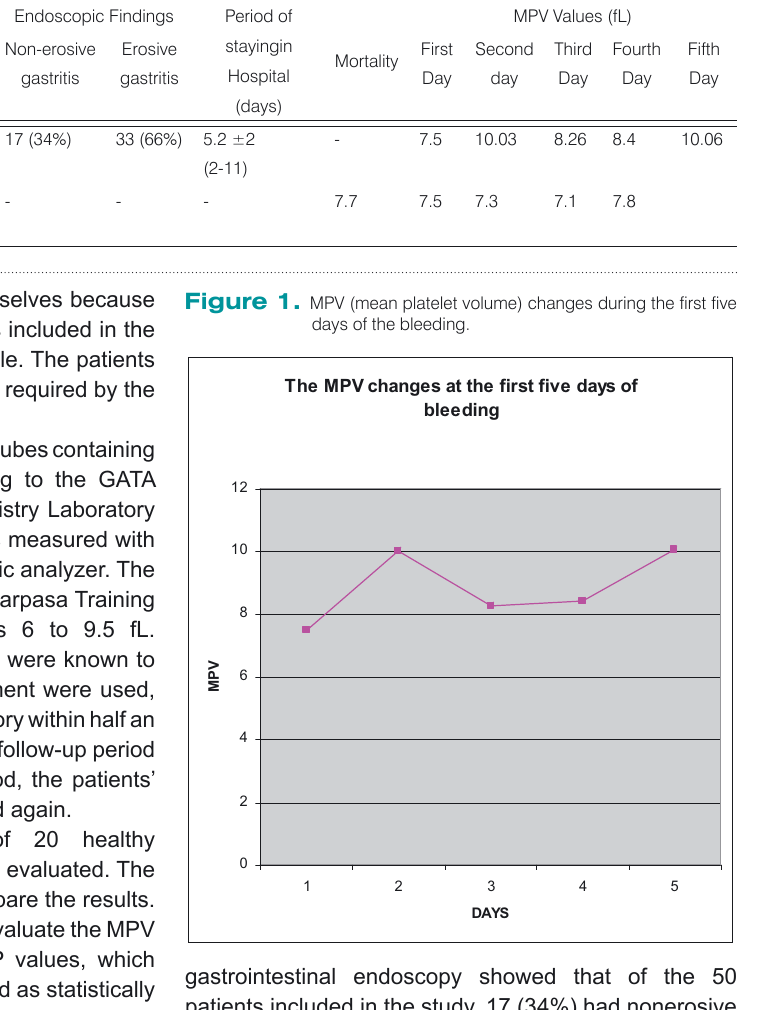
Table 1. Summary of the demographic features of the cases with controls and results of the study.